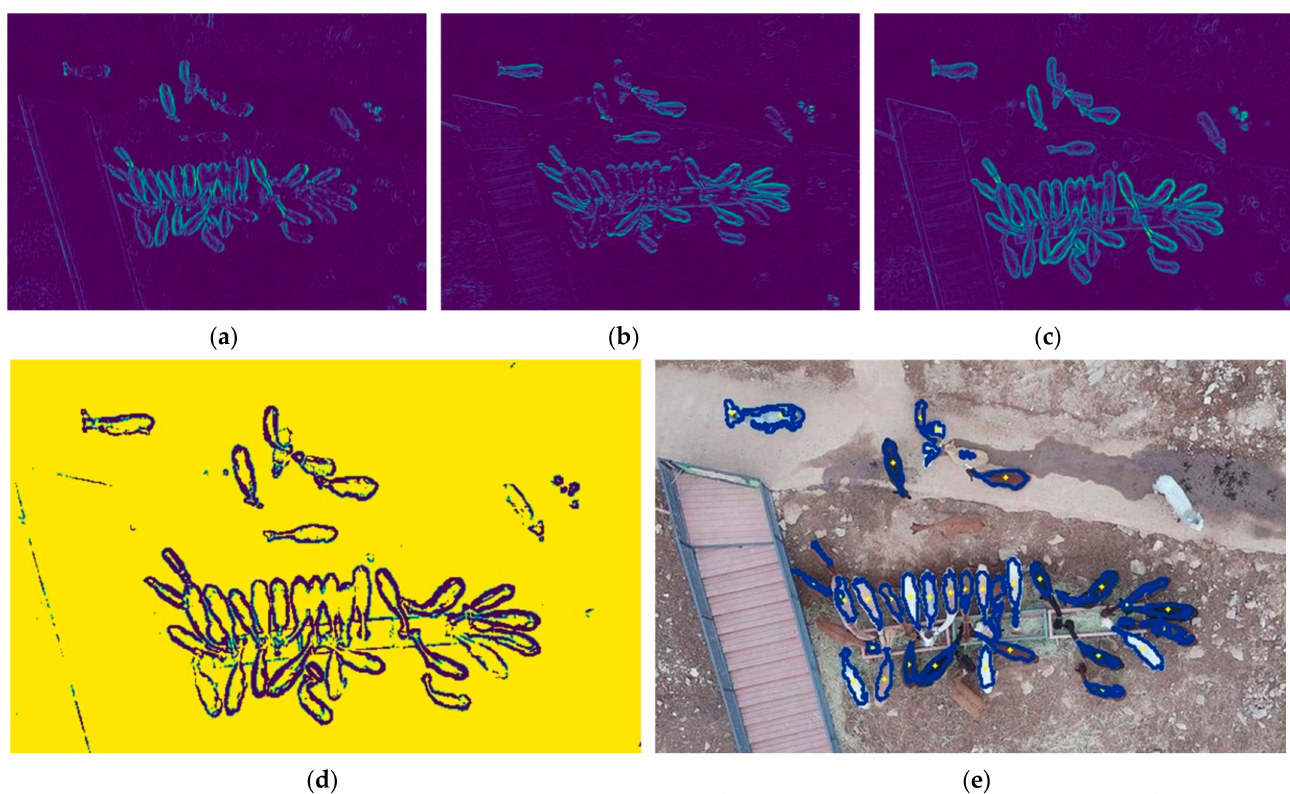
Figure 7. Example of Sobel edge detection and contour drawing. ( a ) Sobel x-axis outcome, ( b ) Sobel y-axis outcome, ( c ) Sobel biaxial outcome, ( d ) thresholded image, and ( e ) contoured